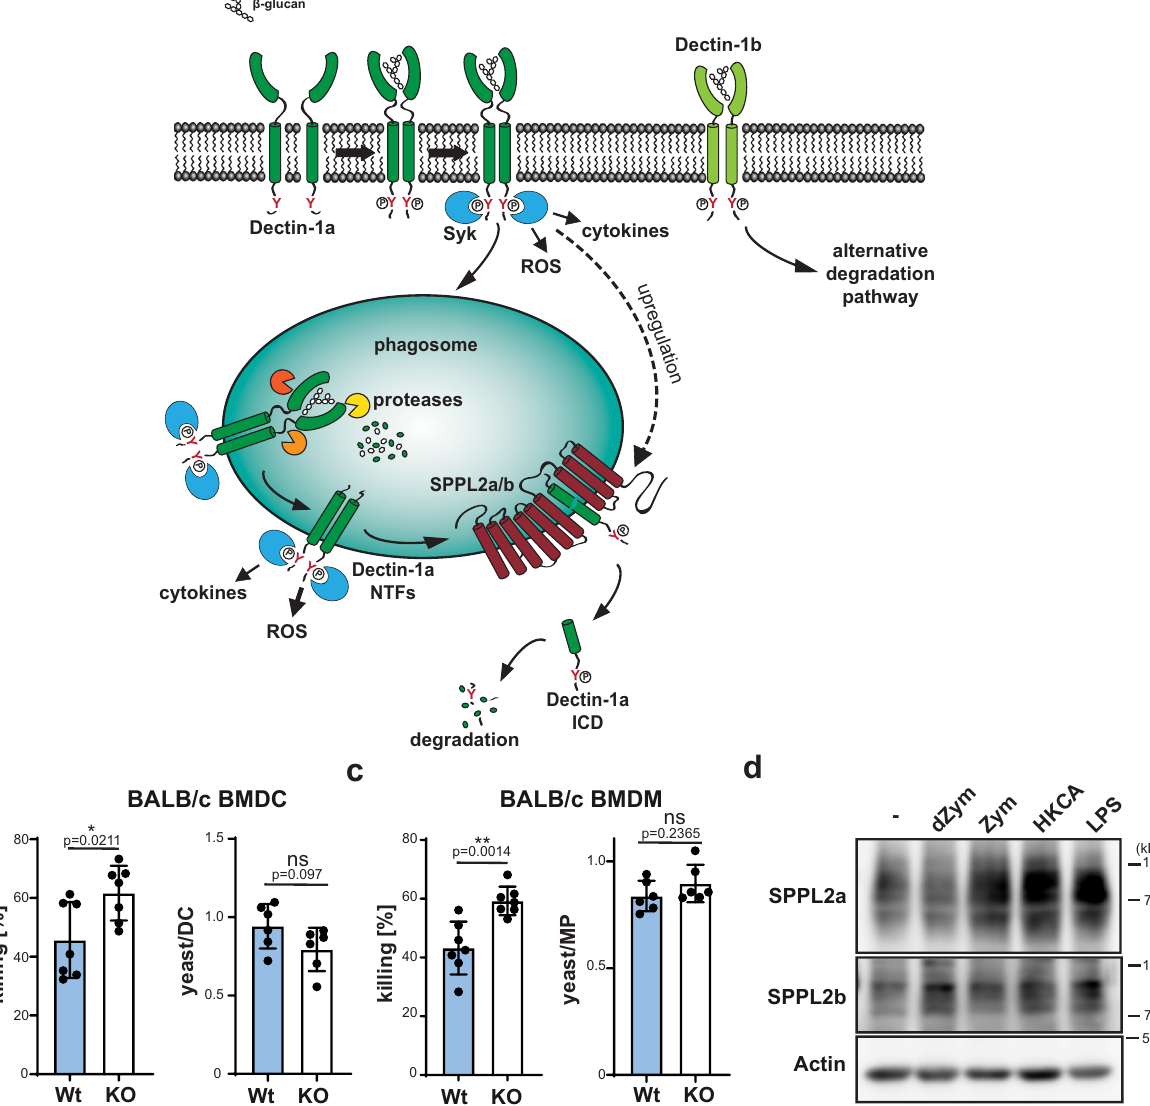
Fig. 7 SPPL2 proteases regulate killing of C. albicans yeasts as part of a regulatory circuit. a Schematic overview of differential processing of Dectin-1 isoforms. Upon ligand binding, Dectin-1a is phosphorylated at the intracellular hemITAM (red Y) leading to the recruitment of kinases including Syk as well as the induction of downstream responses including the formation of ROS and the induction of cytokine secretion. Additionally, ligand binding enforces internalisation of Dectin-1a into phagosomes where it is processed by soluble proteases to a membrane-embedded Dectin-1a NTF. This fragment is still capable of transmitting signalling responses and requires SPPL2a/b for its degradation and termination of Dectin-1a-dependent signal transduction. Dectin- 1b utilises alternative degradative pathways. b Killing as well as phagocytosis of C. albicans yeasts (MOI 1) was assessed for BMDC from either wild type (Wt) or SPPL2b − / − mice (2b KO) mice on BALB/c background. Killing: N = 3, n = 7; phagocytosis N = 2, n = 6. Two-tailed unpaired Student ’ s t test. c The same was done for BMDM derived from the same mice. Killing: N = 3, n = 7; phagocytosis N = 2, n = 6. Two-tailed unpaired Student ’ s t test. d BMDCs from BALB/c wild-type mice were treated for 24 h with either 50 µ g/ml dZym, 50 µ g/ml Zym, MOI 10 HKCA or 500 ng/ml LPS and fi nally monitored for SPPL2a/b protein abundance by western blotting employing speci fi c antibodies against the proteases. N = 4, n = 4. All diagrams depict Mean values ±